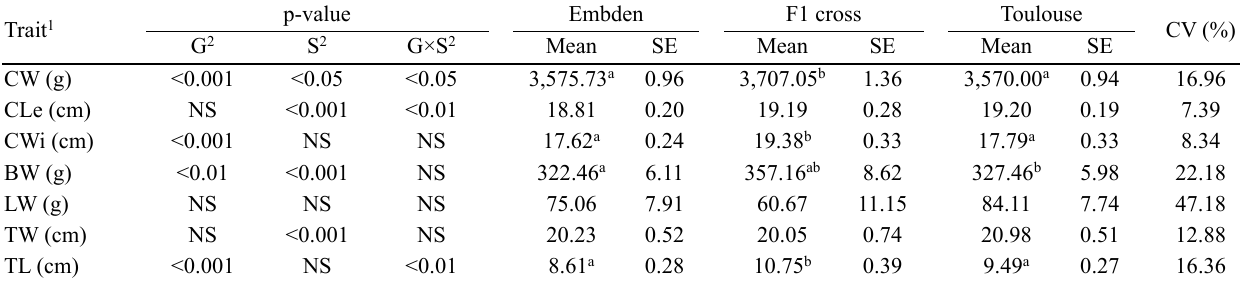
Table 3. ANOVA, descriptive parameters (LS mean and SE) and coefficient of variation of meat quality traits for the three genetic groups of geese raised in the dehesa system analyzed p-value Embden F1 cross Trait 1